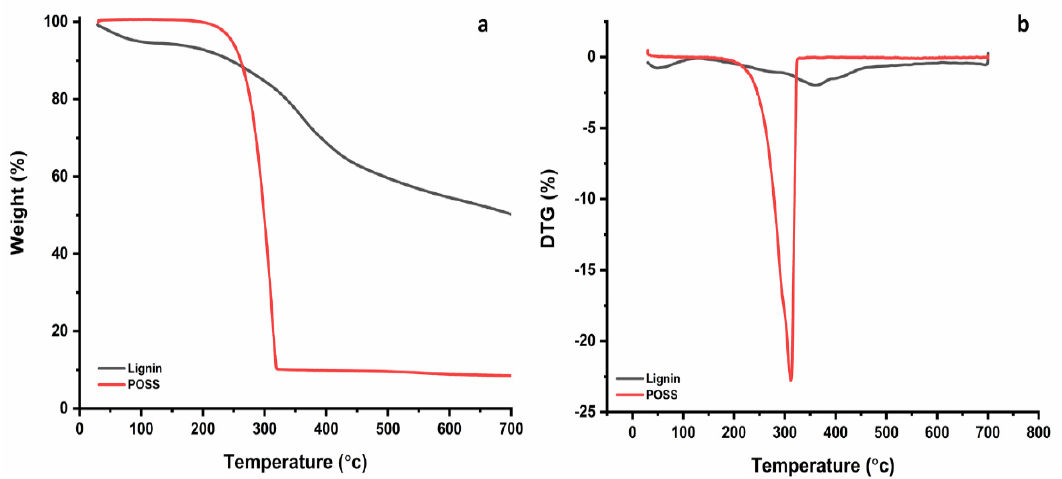
Figure 5. ( a ) Thermal Gravity(TG) curves of lignin and POSS, ( b ) Differential thermogravimetry (DTG) curves of lignin and POSS.